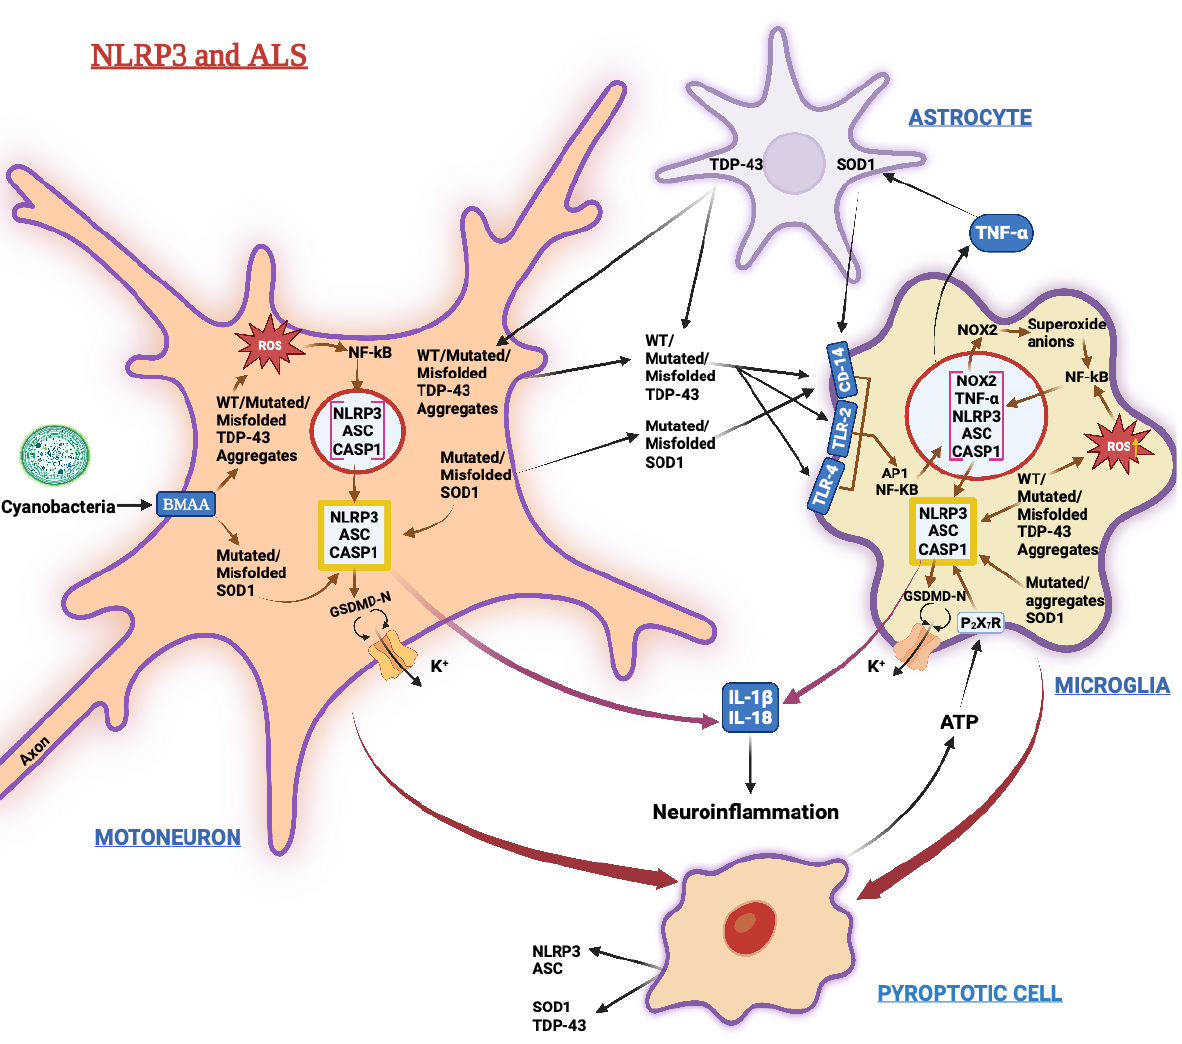
Figure 4. Summary depiction of stressors and factors inducing/modulating motoneurons’ and microglia’s NLRP3 inflammasome’s activation and its consequences in ALS. Mutated/misfolded SOD1 and TDP-43 proteins as variously sized aggregates damage mitochondria, causing in sequence ROS surpluses release, oxidative stress, and NF- κ B pathway signaling. These lead to NLRP3 inflammasome ’ s component overexpression, NLRP3 inflammasome activation, over-release of IL-1 β , IL-18, K + efflux, and eventually motoneurons ’ and microglia ’ s pyroptosis. Exposure to the toxic BMMA amino-acid released by Cyanobacteria worsens the toxic effects of misfolded/mutated SOD1 and TDP-43. Toll-like receptors and CD-14 bind misfolded/mutated SOD1 and TDP-43 activating the AP1/NF- κ B axis, and the expression and activation of NLRP3 inflammasome ’ s components. ATP from pyroptotic cells partakes in NLRP3 activation via P2X 7 receptor signaling (see Box 2 for details). Astrocytes also release misfolded/mutated SOD1 and TDP3 that are engulfed by other neural cells, thus spreading the neuropathology. Moreover ATP, pyroptotic cells also release NLRP3, SOD1, TDP-43, and ASC proteins that contribute to the neuroinflammation. A yellow frame encloses the assembled inflammasomes, while nuclear envelopes are orange-colored. Abbreviations: AP1 = activator protein 1; ASC = apoptosis-associated speck-like protein endowed with a CARD domain; BMAA = β -methylamino-L-alanine; CASP1 = caspase-1; CD14 = cluster of differentiation 14; GSDMD-N = gasdermin D N-terminal fragments; NF- κ B = nuclear factor κ B; NOX2 = NADPH oxidase 2; P2X 7 R = purinergic receptor; ROS = reactive oxygen species; SOD1 = superoxide dismutase 1; TDP-43 = TAR DNA-binding protein 43; TLR − =Toll-like receptor − ; TNF- α = tumor necrosis factor- α ; WT = wild-type. The arrows show the sequences of molecular events induced by stressors and factors.